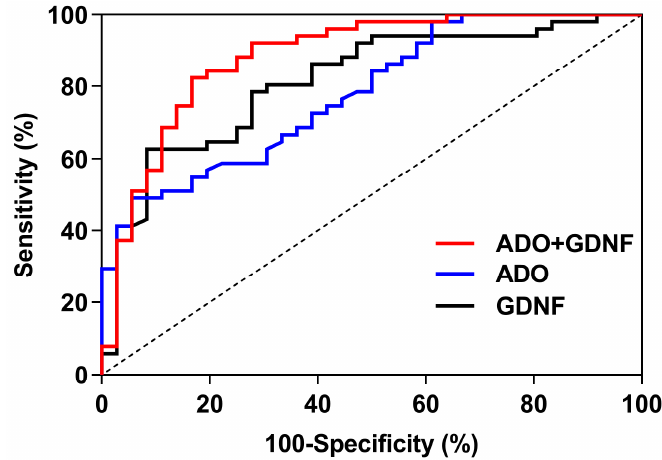
Table 6. Logistic regression of sleep disorders in PD patients.